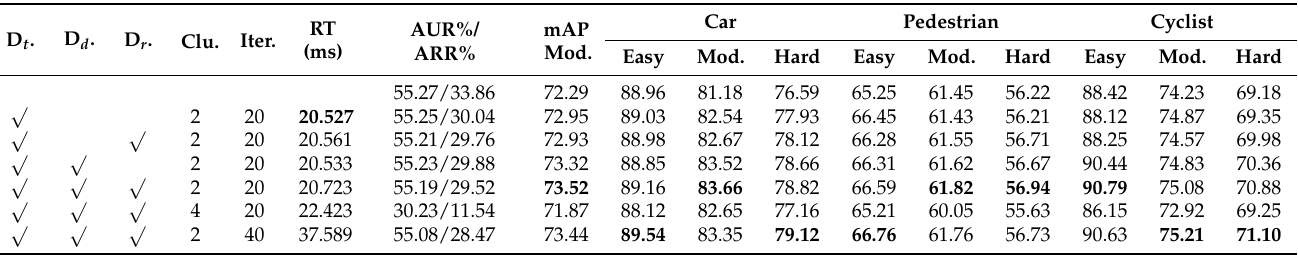
Table 8. Ablation results of the clustering conditions and execution configuration of the K-means on the KITTI validation set. Abbreviations: D texture (D t . ), D depth (D d . ), D reflectivity (D r . ), clusters (Clu.), iteration (Iter.), run time